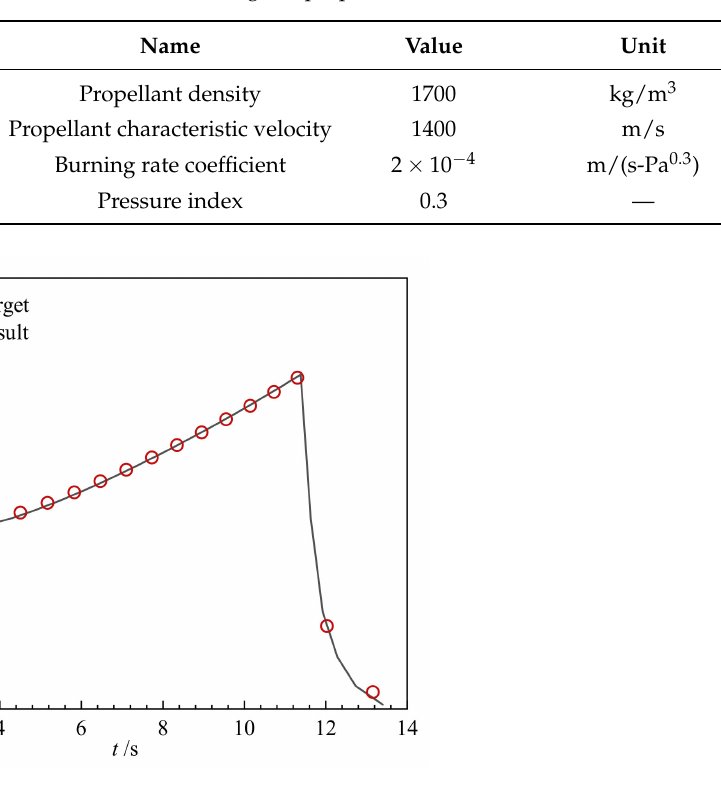
Figure 21. Relation between the combustion chamber pressure and the burning time of the designed